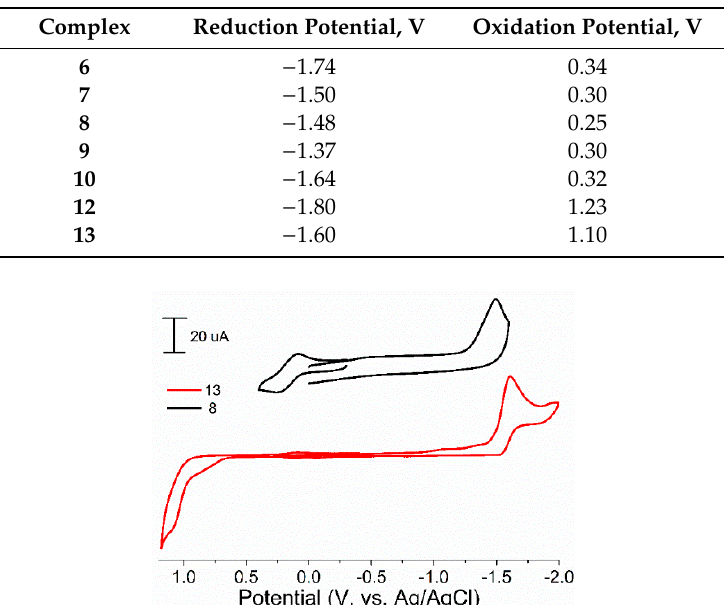
Table 2. Electrochemical data for iron complexes 6 – 13 in MeCN (potentials vs. Ag/AgCl reference electrode).